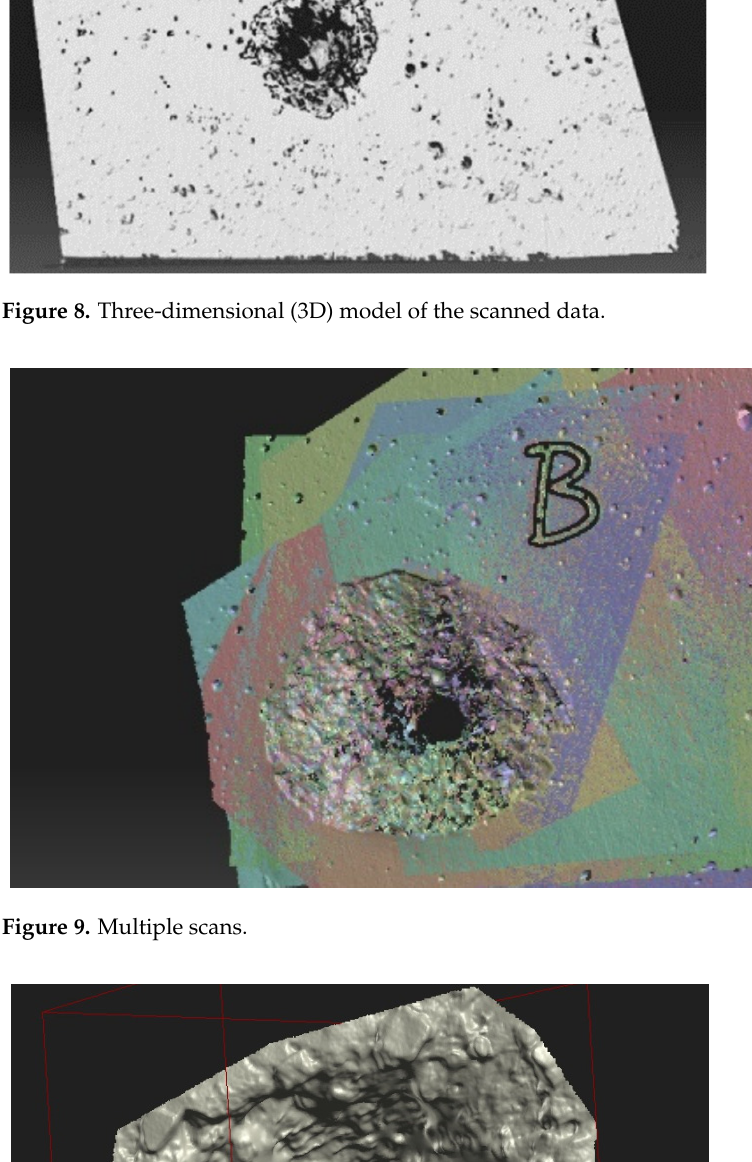
Figure 8. Three-dimensional (3D) model of the scanned data.